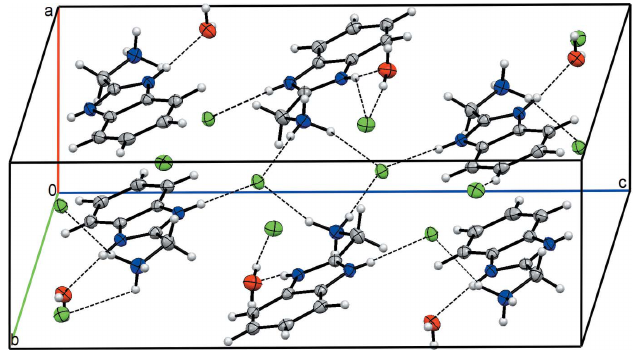
Figure 2 The view of the crystal packing of the title compound. Dashed lines denote the hydrogen bonds.